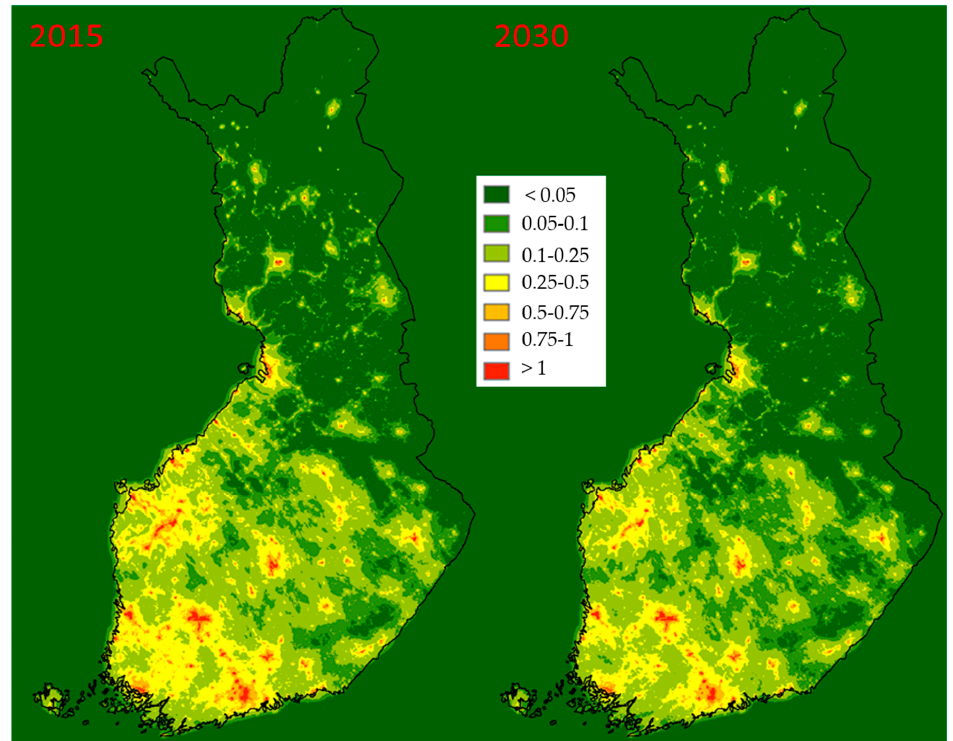
Figure 2. The PM 2.5 concentrations [ µ g / m 3 ] resulting from RWC in 2015 and the baseline scenario in